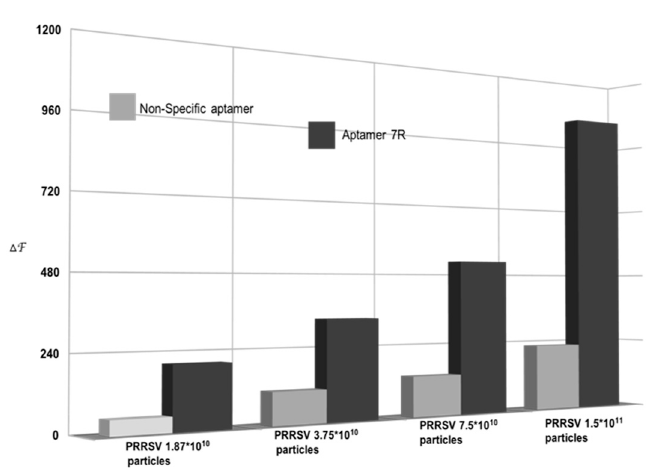
Figure 2. QCM frequency shifts PRRSV 1.87 * 10 10 particles/Ml–1.5 * 10 11 particles/mL.